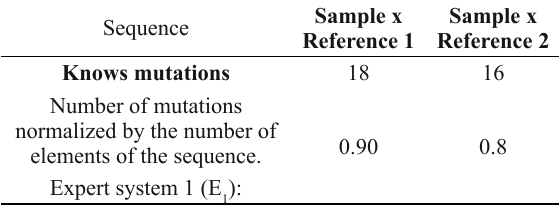
Veri fi cation the quantity of known mutations.